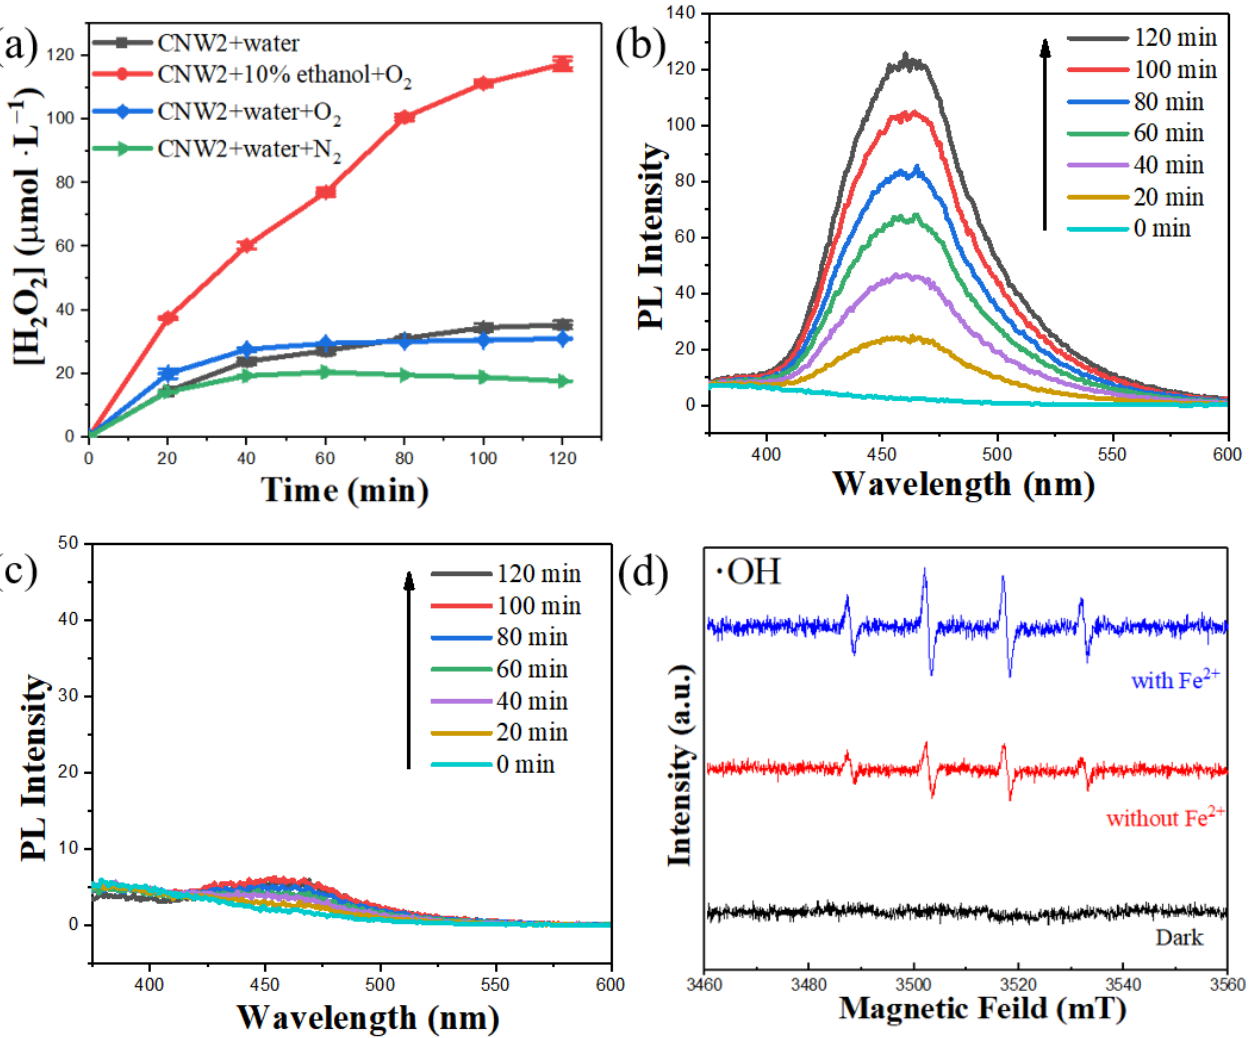
Figure 9. ( a ) Photocatalytic H 2 O 2 production under different conditions (including CNW2 + water, CNW2 + 10% ethanol + O 2 , and CNW2 + water + O 2 , CNW2 + water + N 2 ) for CNW2, fluorescence spectra of 1 mM coumarin solution ( b ) with Fe 2+ and ( c ) without Fe 2+ under visible light irradiation; ( d ) EPR spectra of DMPO spin-trapping adducts for CNW2 dispersion with and without Fe 2+ .